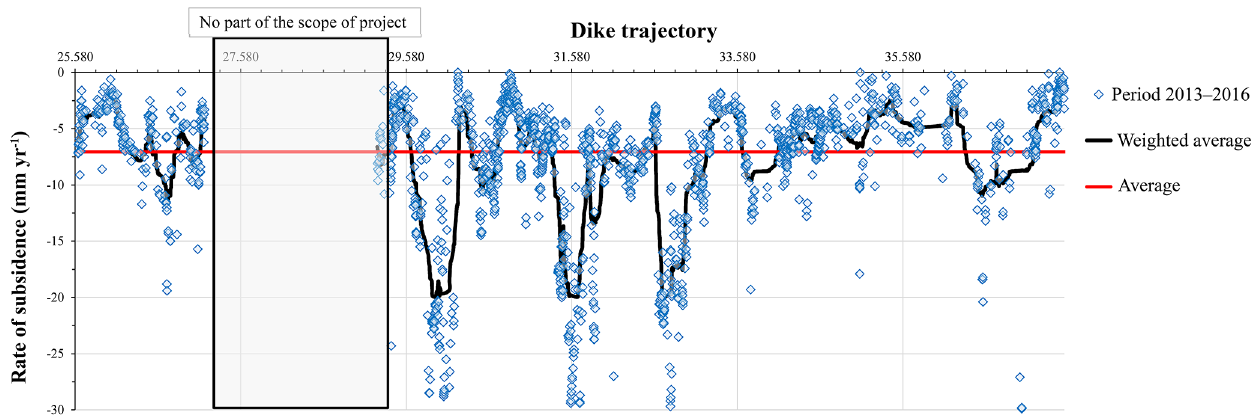
Figure 3. Determination of average subsidence rate based on INSAR measurements from the period